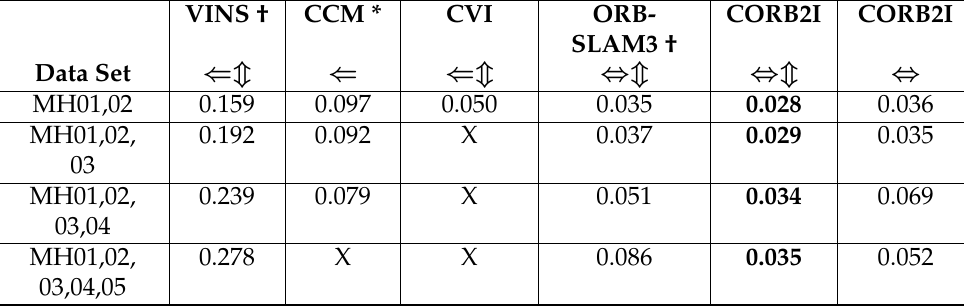
Table 2. The RMS ATE (meter) of multiple agents for experiments on EuRoC sequences. † indicates that the sequences are run sequentially because the system is designed for a single agent and the rest of the symbols have the same meanings as in Table 1.